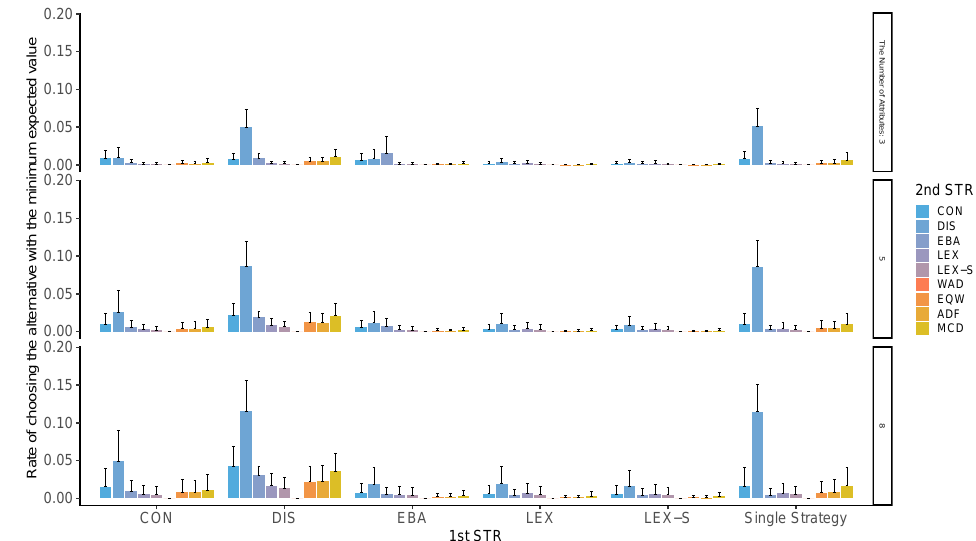
Figure A12. Worst choice rate in two-stage decision-making when three alternatives are left in the second stage for the different numbers of attributes. Note: ADF: additive difference; CON: conjunctive; DIS: disjunctive; EBA: elimination by aspects; EQW: equal-weighted strategy; LEX: lexicographic; LEX-S: lexicographic semi-order; MCD: majority of confirming dimensions; STR: strategy; WAD: weighted